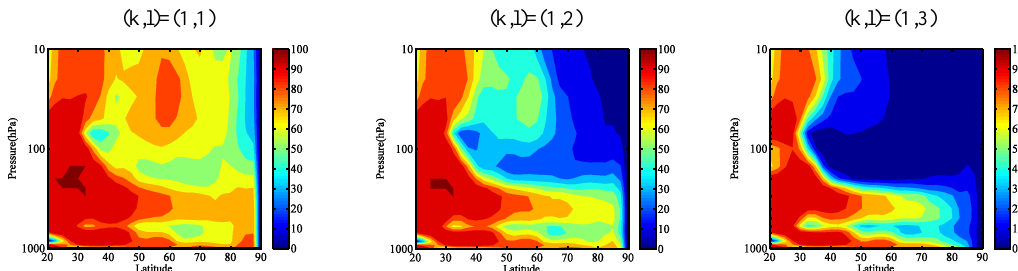
Figure 4. Probability of positive vertical wave number squared for Northern Hemisphere wintertime for wave (1 , 1), (1 , 2) and (1 , 3).